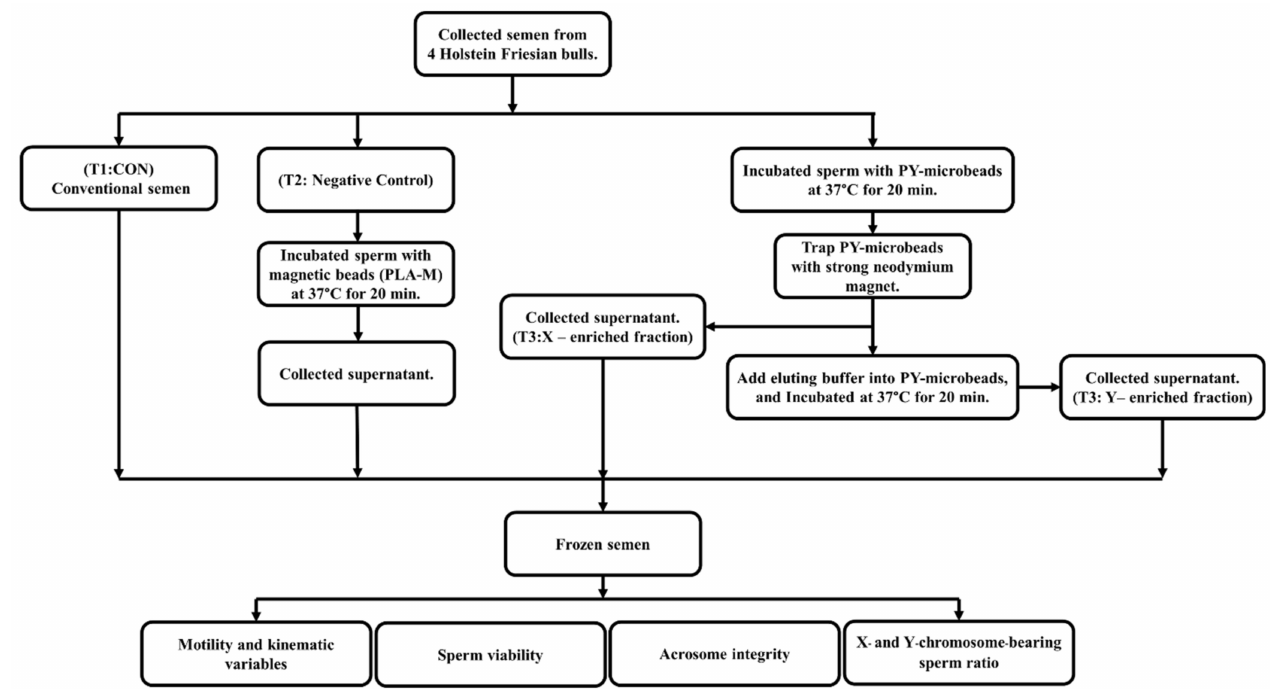
Figure 2. A diagram of the steps involved in magnetic-activated cell sorting for sexing bovine semen production and the evaluation of bovine semen in the present